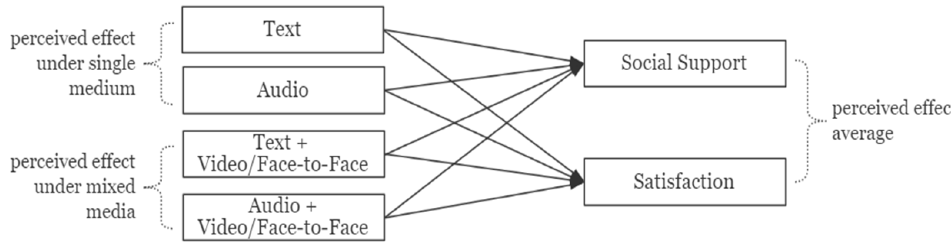
Figure 2. Research model 2.